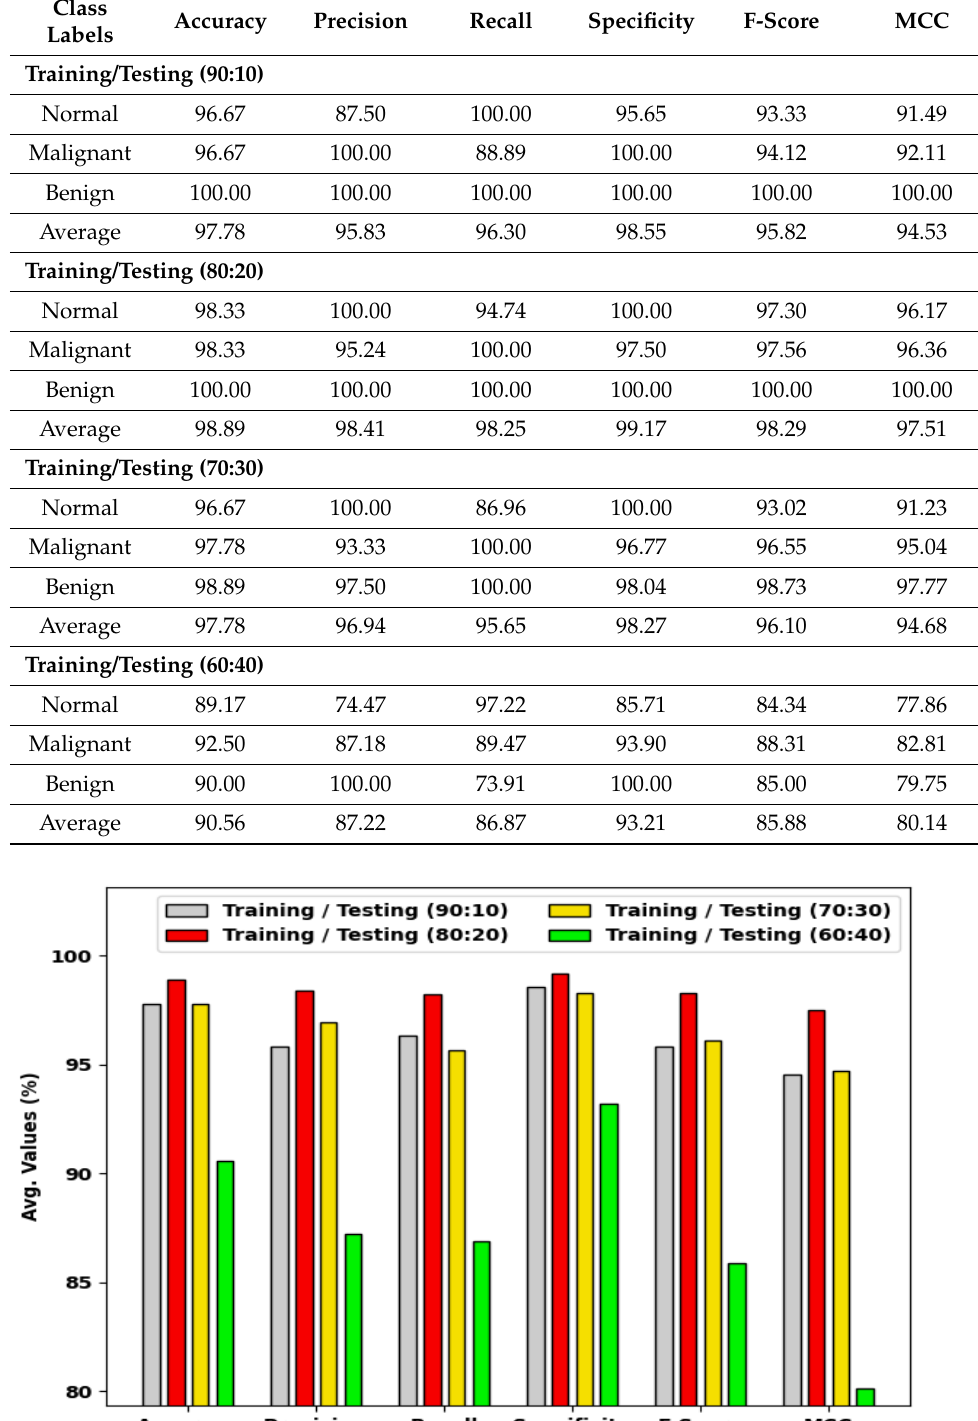
Table 1. Analysis results of the CSO-CADLCC technique under distinct classes and TR/TS data. Class Labels